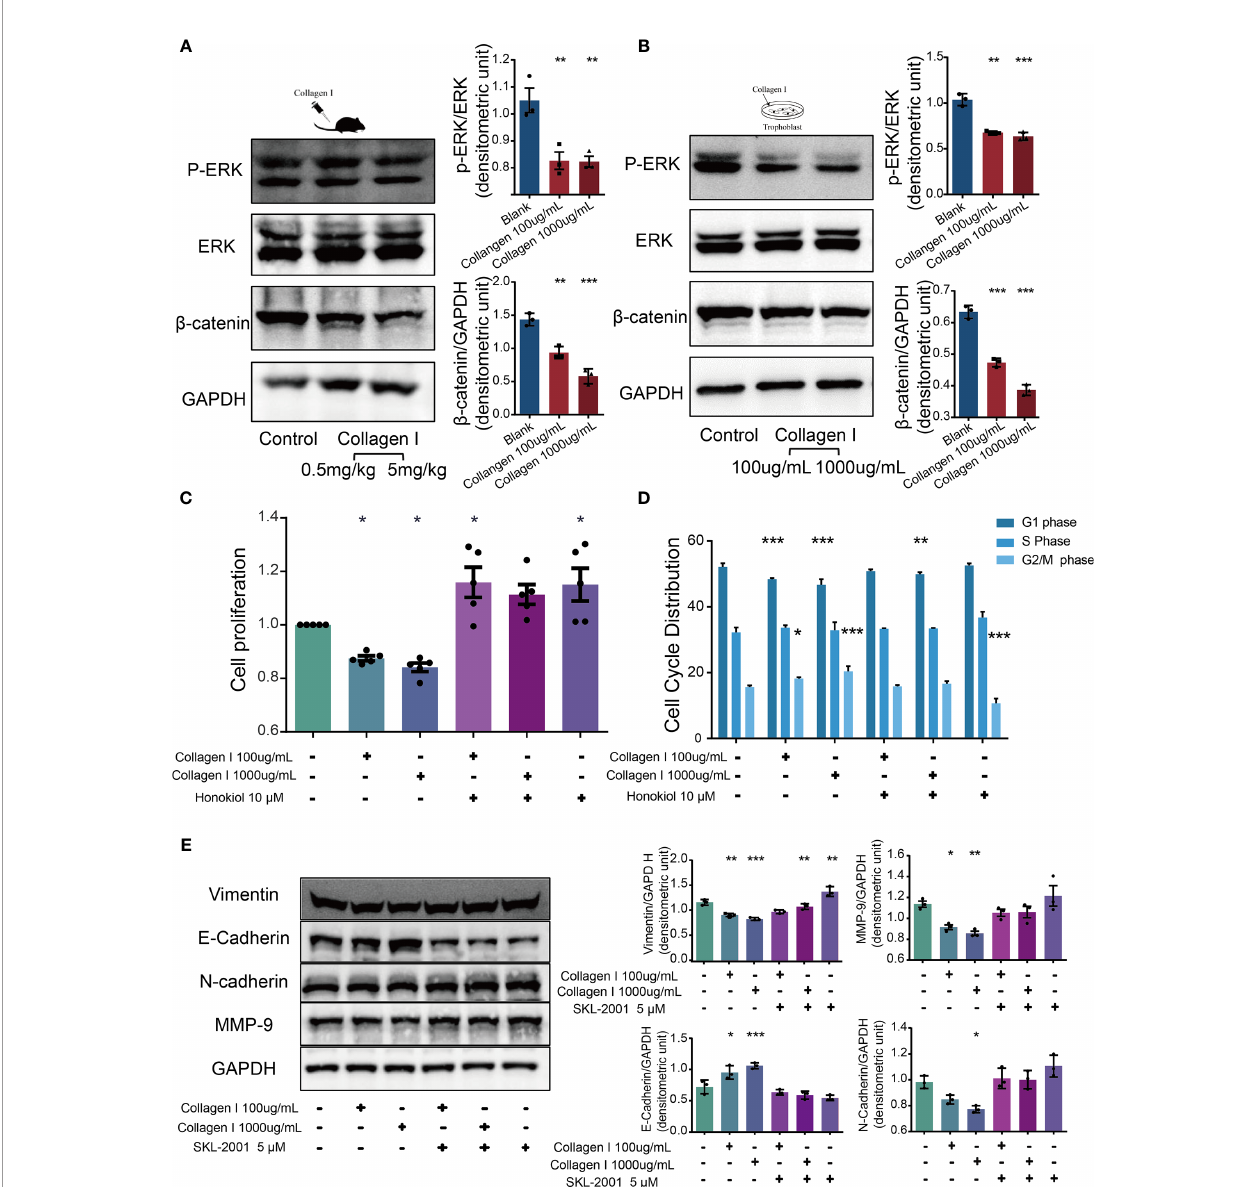
FIGURE 5 | Collagen I suppressed proliferation and invasion of trophoblasts through inhibition of ERK phosphorylation and the WNT/ b -catenin signaling pathway. Honokiol and SKL-2001 reversed the decrease in proliferation and invasion ability of trophoblasts induced by collagen I. (A) Representative western blot image and quantitative analysis of p-ERK, ERK, and b -catenin levels in collagen I-treated mouse placentas (n = 3 per group). (B) Representative western blot image and quantitative analysis of p-ERK, ERK, and b -catenin levels in collagen I-treated HTR-8/SVneo cells (n = 3 per group). (C) After incubation with honokiol and collagen I for 48 hours, HTR-8/SVneo cell proliferation was measured by CCK-8 assay (n = 5 per group). (D) After incubation with honokiol and collagen I for 48 hours, cells were labelled with propidium iodide (PI) and the stain was detected by LSC. Bar plots representing the proportion of cells at each phase of the cell cycle (G1, S, and G2/M phases) in three different cell groups (n = 5 per group). (E) Representative western blot image and quantitative analysis of MMP-9, vimentin, E-cadherin, and N-cadherin levels in collagen I- and/or SKL-2001-treated HTR-8/SVneo cells (n = 3 per group). Asterisks indicate differences between groups vs. control, with *p < 0.05, **p < 0.01, and ***p < 0.001, according to one-way ANOVA followed by Dunnett ’ s post-hoc